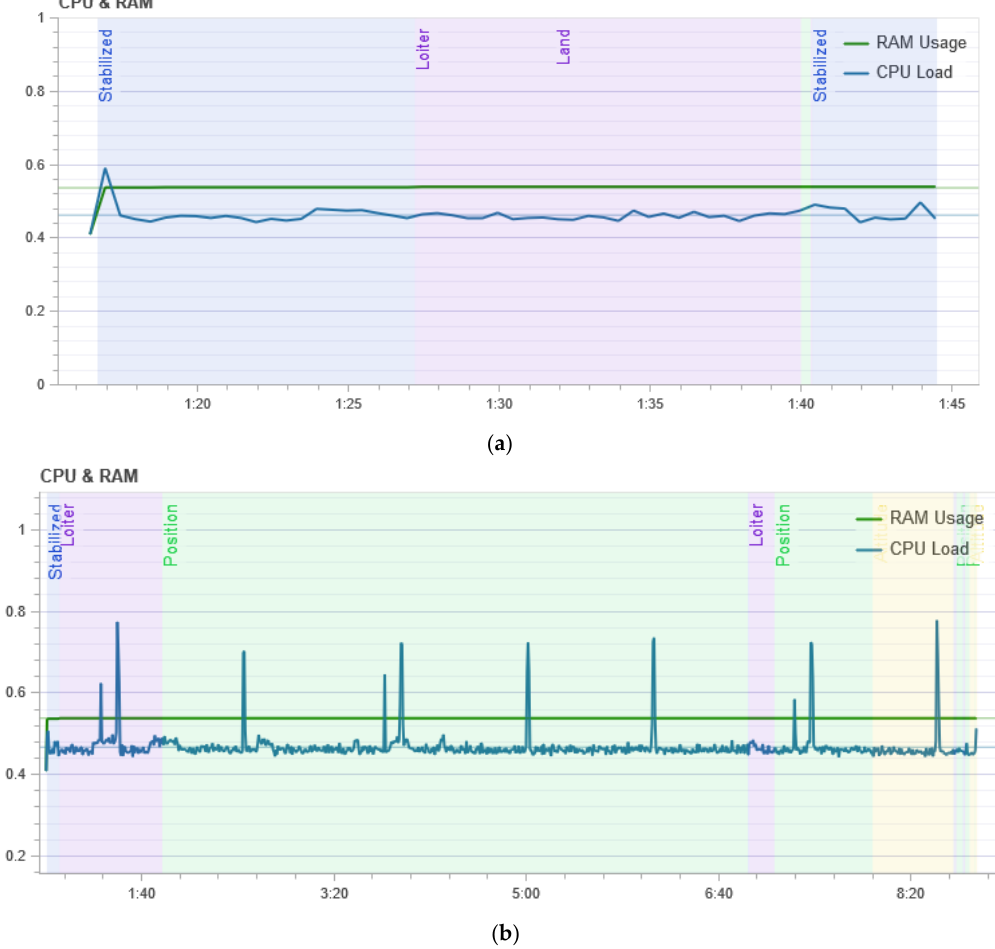
Figure 10. Loading the UAV processor: ( a ) In the normal mode; and ( b ) during a GPS attack. From Figure 5b we can see that the flight altitude is rather uneven during the attack, especially in the last time intervals when there is a sharp rise. This change in altitude is correlated with the calculation of entropy which is shown in Figure 1. The figure shows an increase in the entropy for the flight altitude indicator, which indicates the presence of an anomaly. The parameter number of GPS satellites constantly changes during an at- tack, and this is clearly seen from Figure 6b. If there is no attack, this graph looks like a straight line. At the same time, it can be seen from Figure 2 that in the second time in- terval the level of divergence has already grown significantly. This indicates the presence of serious changes in the system and may indicate an anomaly. At the same time, we draw attention to the fact that the numbers with a change in the altitude and the number of satellites have different orders, but for our method, this turns out to be not important. Due to the use of the probability distribution, we can recognize that the value of the di- vergence has increased by more than two and this is enough to detect the anomaly. Unlike previous work [23–26], we do not need to know which behavior is consid- ered normal, or to compose many training datasets. It is enough for the UAV system to obtain one value and it does not need to be compared with a normal value, as in other approaches [8–12]. Our solution compares observable variables only using their own value in the previous and current periods of time. From Figure 7a, which shows the result of measuring the GPS noise level, it can be seen that even during normal operation the graph is not a straight line and some noise is evident with changes in its level. At the same time, as shown in Figure 3b, the Kull- back-Leibler divergence is at a low level, that is, the system does not consider this be- havior an anomaly. This is due to several factors. Firstly, the change in the noise level with normal behavior is not significant. Secondly, due to the algorithm for processing incoming data, which is presented in Section 2, during data processing, the series are constructed in such a way that the probability distribution does not change its form too much with small changes. This cannot be said about the situation with the GPS noise during an attack. In this situation it changes significantly, as can be seen from Figure 7b. As a result, the diver- gence value during the attack is quite high immediately after the first interval, as can be seen in Figure 3a. Even though the attack is directed at the GPS system, it ultimately affects several parameters at once. These are both the flight altitude and GPS noise and the number of GPS satellites and the level of CPU utilization and energy consumption. For other attacks, such as the eavesdropping attack presented by Wang et al. [31], other sets of parameters